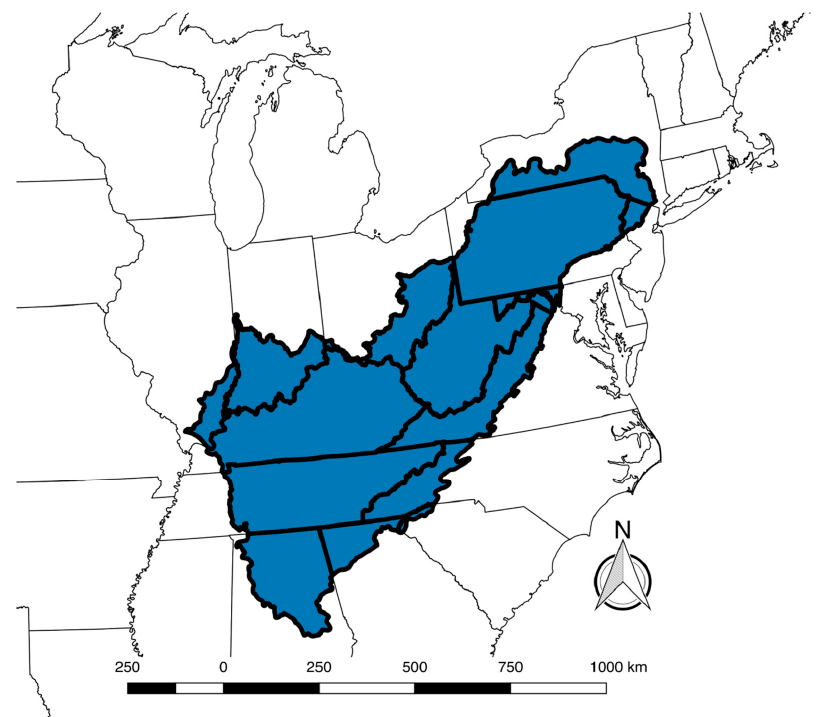
Figure 1. Overview map of the Appalachian Landscape Conservation Cooperative [21]. Map created by R. Daniel Hanks using ArcGIS v10.3